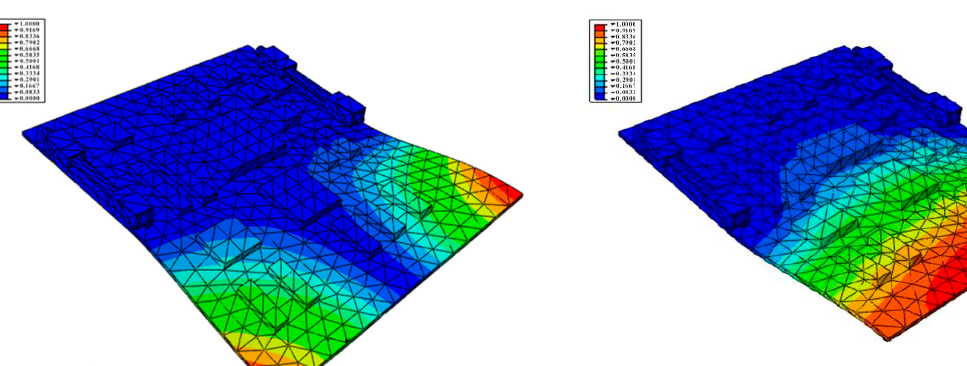
Table 2. First six natural frequencies of CPU board.